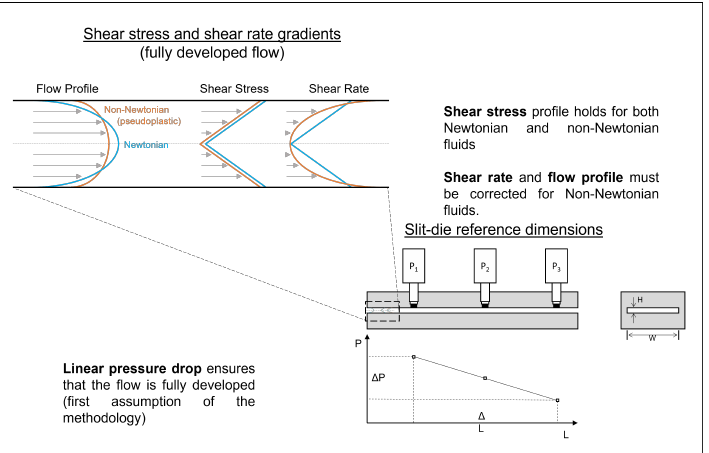
Figure 1. Shear rate determination requires special data treatment in the case of a non-Newtonian fluid. The Weissenberg–Rabinowitsch–Mooney correction is applied to the apparent shear rate to obtain the wall shear rate (Equation